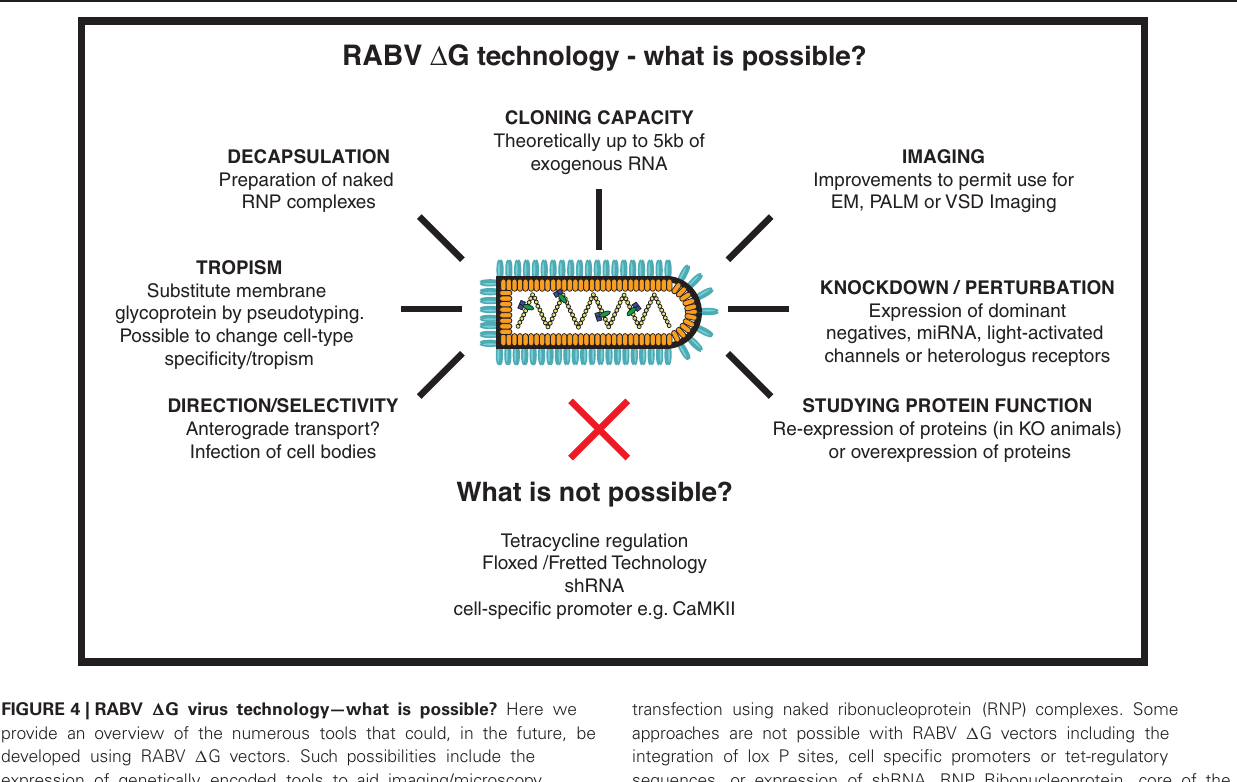
transfection using naked ribonucleoprotein (RNP) complexes. Some approaches are not possible with RABV (cid:2) G vectors including the integration of lox P sites, cell specific promoters or tet-regulatory sequences, or expression of shRNA. RNP, Ribonucleoprotein, core of the RABV; EM, Electron microscopy; PALM, Photo-activated localization microscopy; VSD, Voltage-sensitive dye; miRNA, micro RNA; shRNA, short hairpin